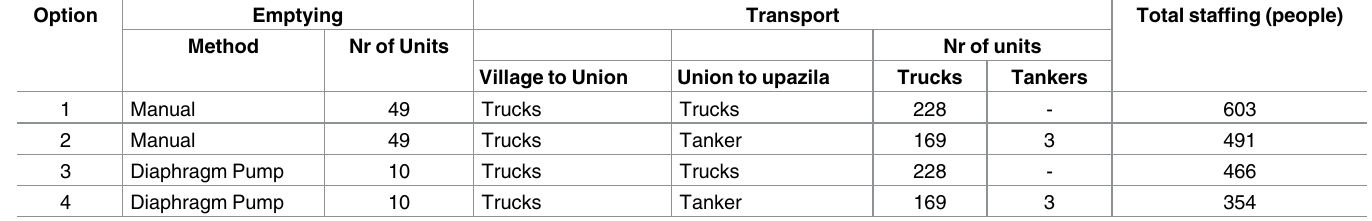
Table 6. Summaryof emptying and transport solutions.